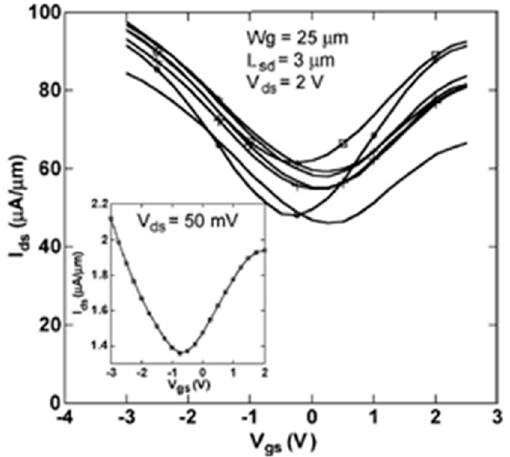
Figure 21. Ambipolar field-effect transistor on Si (111) substrates. Reprinted with permission from Reference [80]. Copyright (2010) Institute of Electrical and Electronics Engineers.